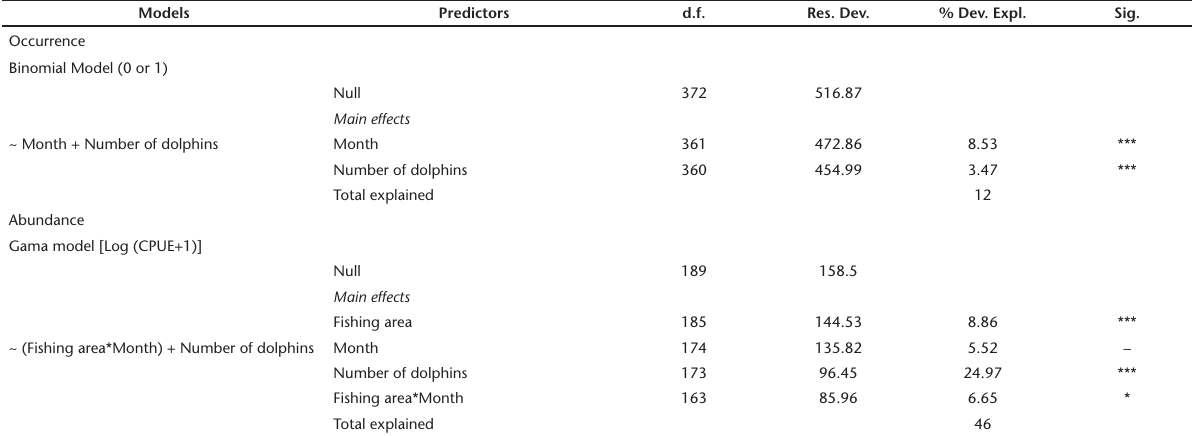
Table 3. Analyses of deviances for the generalized linear model that best explains the occurrence (binomial model) and abundance